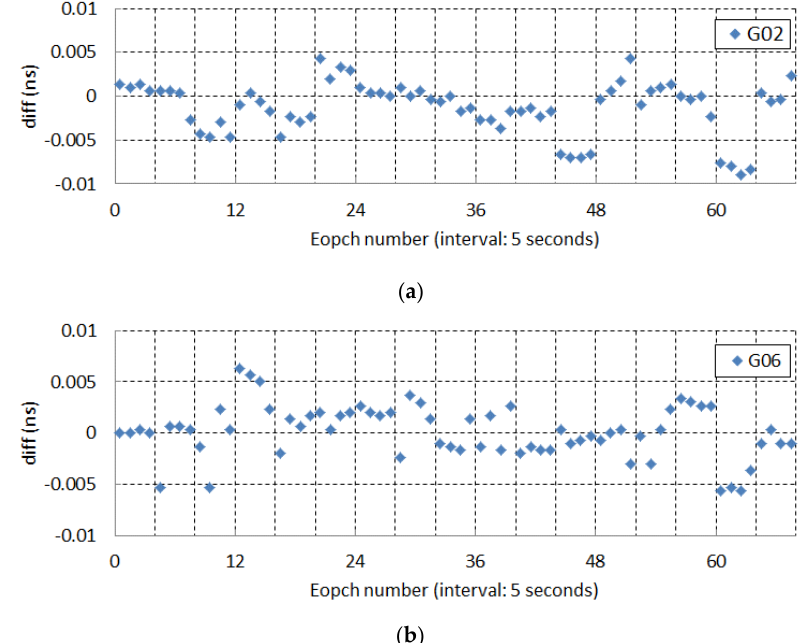
Figure 8. ( a ) Detailed differences between decentralized clock estimation (DECE) and undifferenced (UD) clock (G02). ( b ) Detailed differences between DECE and UD clock (G06).